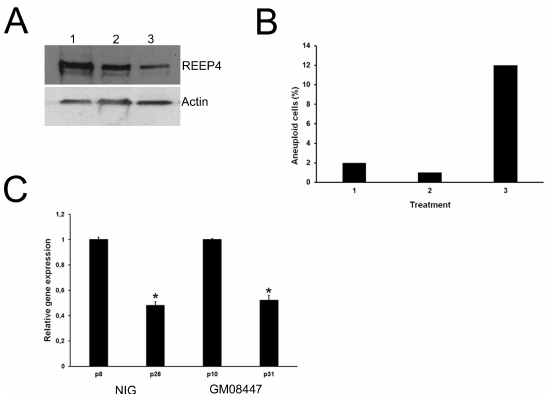
Figure 4. E ff ect of REEP4 depletion in human primary fibroblasts. ( A ) Western blotting showing the downregulation of REEP4 in human fibroblasts treated with 20 nM of smart pool siRNA (3) when compared with untreated (1) and mock siRNA-treated cells (2). ( B ) REEP4 silencing (3) led to high frequency of aneuploidy cells when compared with untreated (1) and mock siRNA-treated cells. ( C ) The expression of REEP4 was analyzed in three independent biological replicates of NIG (young and old) and GM08447 (young and old) cell lines. It was higher in young (p8 and p10 for NIG and GM08447, respectively) than in old fibroblasts (p28 and p31 for NIG and GM08447, respectively). Error bars represent standard deviation. * p <